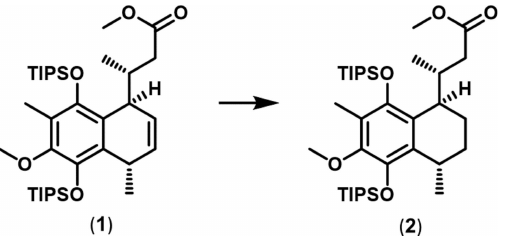
Figure 7 Synthesis scheme to obtain compound ( 8